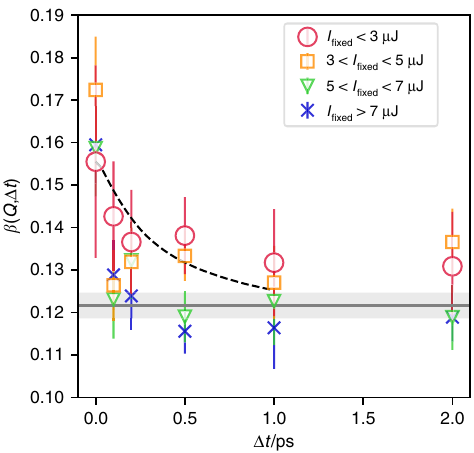
Fig. 5 X-ray speckle contrast obtained by maximum-likelihood estimation. At Q = 2.00 ± 0.06 Å − 1 with (circles) I fi xed < 3 µ J, (squares) 3 µ J < I fi xed < 5 µ J, (triangles) 5 µ J < I fi xed < 7 µ J, and (crosses) I fi xed > 7 µ J. (diamonds). The solid line represents the contrast measured when there was no overlap between two sub-pulses. The uncertainty was calculated using the second derivative of the log-likelihood based on the approach in ref. 20 , and the uncertainty for the solid line is represented by the shade. The dashed line represents the decaying behavior 48,49 , which are estimated by the result of inelastic X-ray scattering where their amplitude was set by the XSVS result at Δ t =